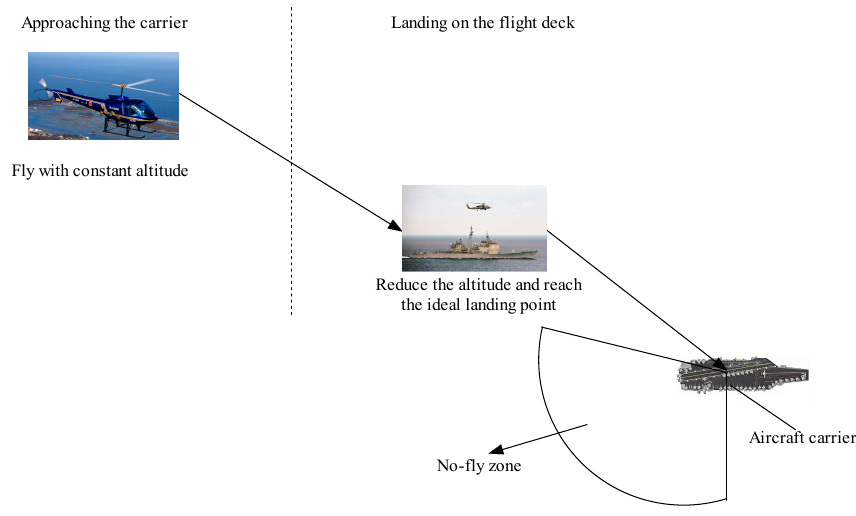
Figure 1. Description of the landing task for the helicopter.